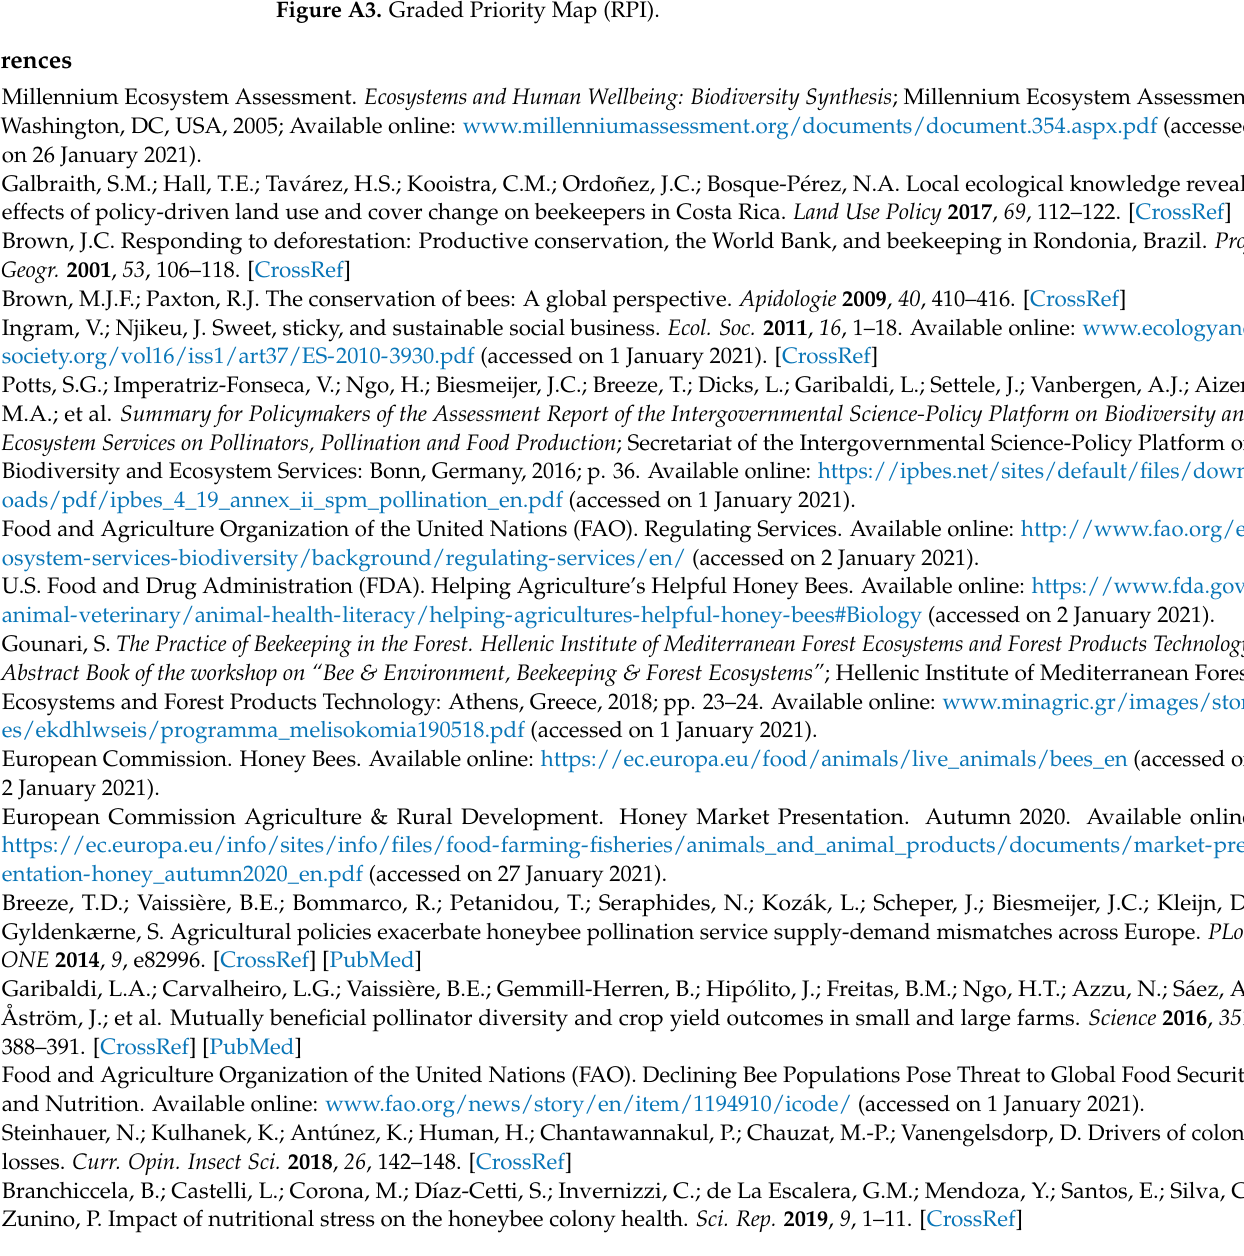
Figure A3. Graded Priority Map (RPI).